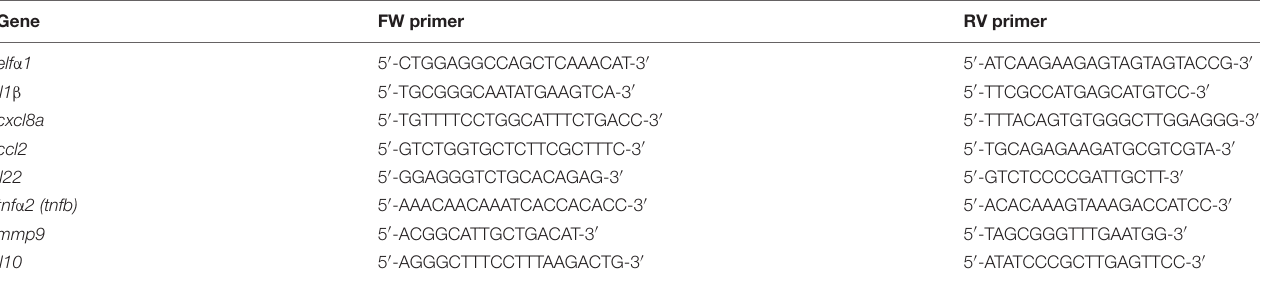
TABLE 1 | Forward (FW) and reverse (RV) sequences of the primers employed for the Real Time